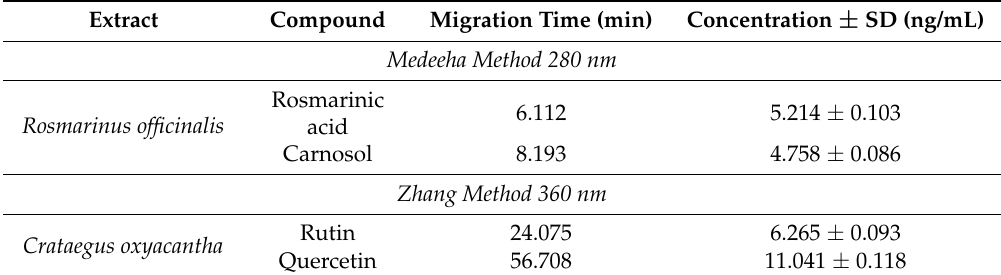
Figure 1. Chromatography of the foliar extract of Rosmarinus officinalis ( a ) compared to the chromatogram at 280 nm of the standards rosmarinic acid and carnosol ( c ); Crataegus oxyacantha ( b ) compared to the chromatogram at 360 nm of the rutin and quercetin standards ( d ). Table 1. Migrations times of polyphenolic compound found in the extracts of Rosmarinus officinalis and Crataegus oxyacantha .